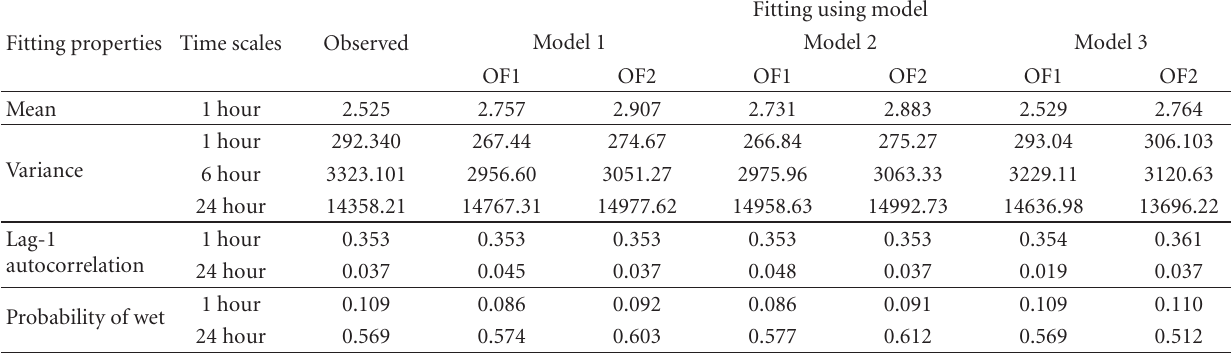
Table 4: Observed rainfall statistics for November with corresponding properties for the fitted models.